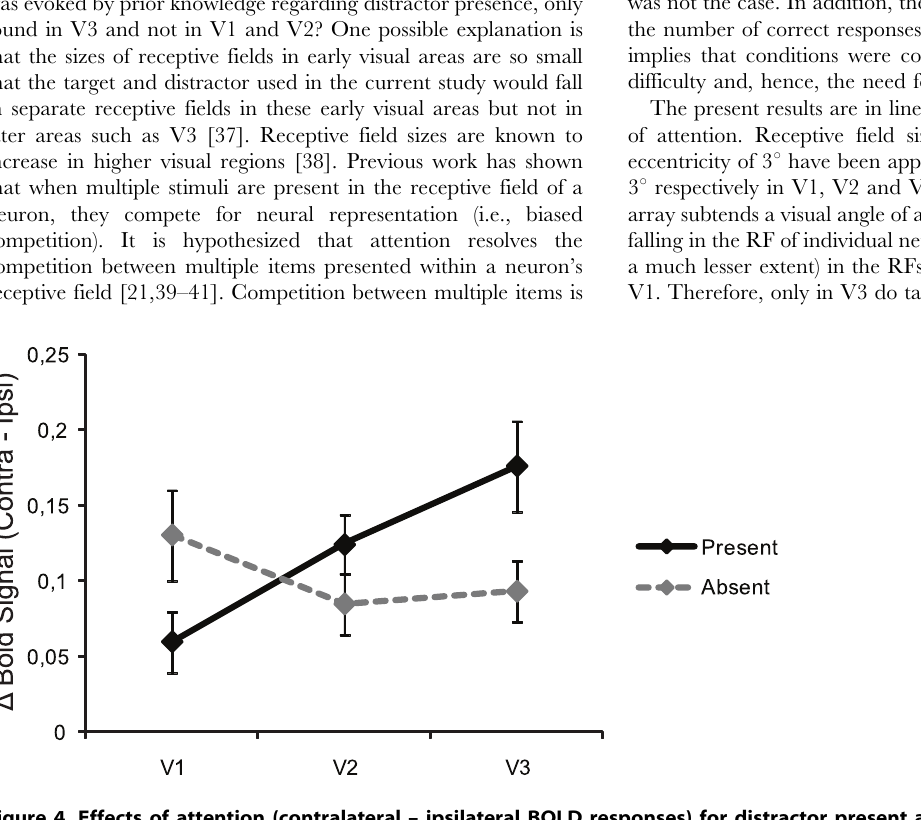
Figure 3. Obtained time courses and averaged BOLD signal. A) Deconvolved time courses of the four trial types measured from cue onset. B) Average signal calculated over the peak of the BOLD response (TR3 – TR5; 1 TR=1.8 s). Regions of visual cortex contralateral to the cued visual hemifield showed larger responses compared to ipsilateral regions in all ROIs during this interval. There was no main effect of distractor expectation, but in V3, an interaction between laterality and distractor expectation was observed for this interval, showing that preparation for a distractor had the largest effect at contralateral sites. Error-bars reflect standard-error corrected for the use of a within-subjects design.